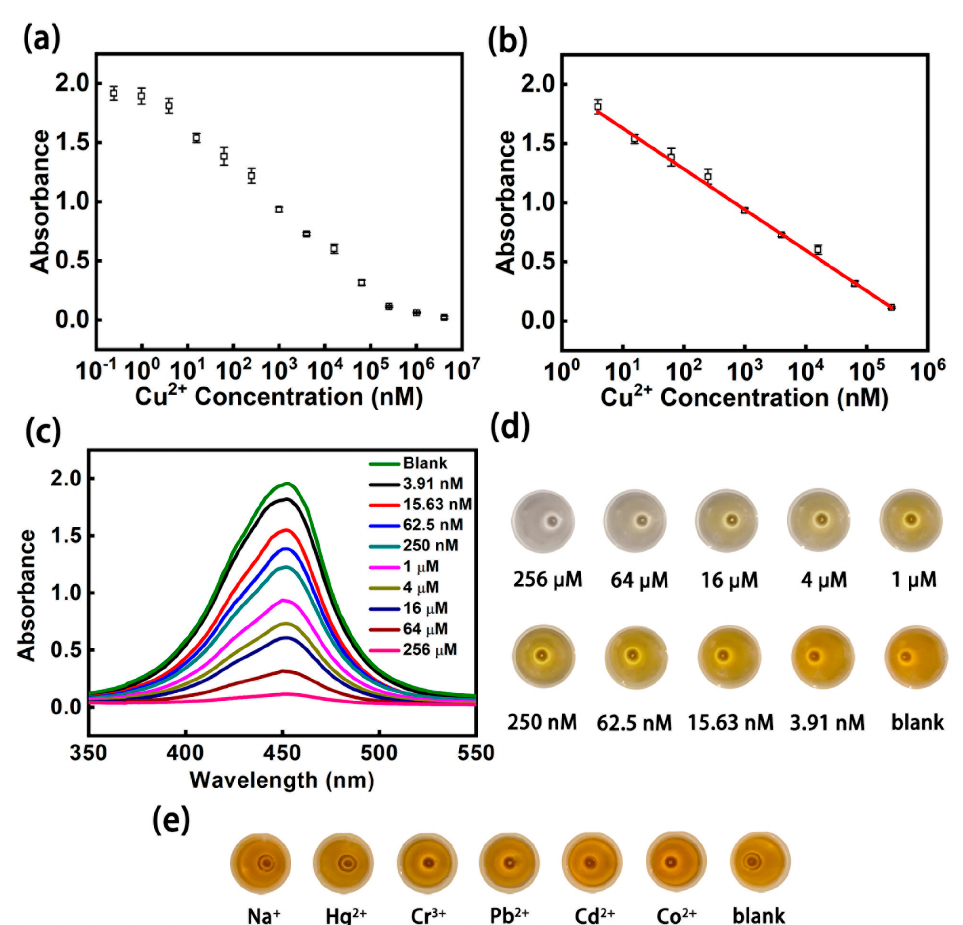
Figure 4. The detection performance of the biological logic gates: ( a ) detecting results of Cu 2+ in the range of 0.24 nM–4096 μ M. ( b ) Linear curve of Cu 2+ at 3.91 nm–256 μ M. ( c ) Uv-vis spectra of Cu 2+ at different concentrations in the linear range. ( d ) Color results of different concentrations of Cu 2+ in the linear range. ( e ) Color results of other metal irons.